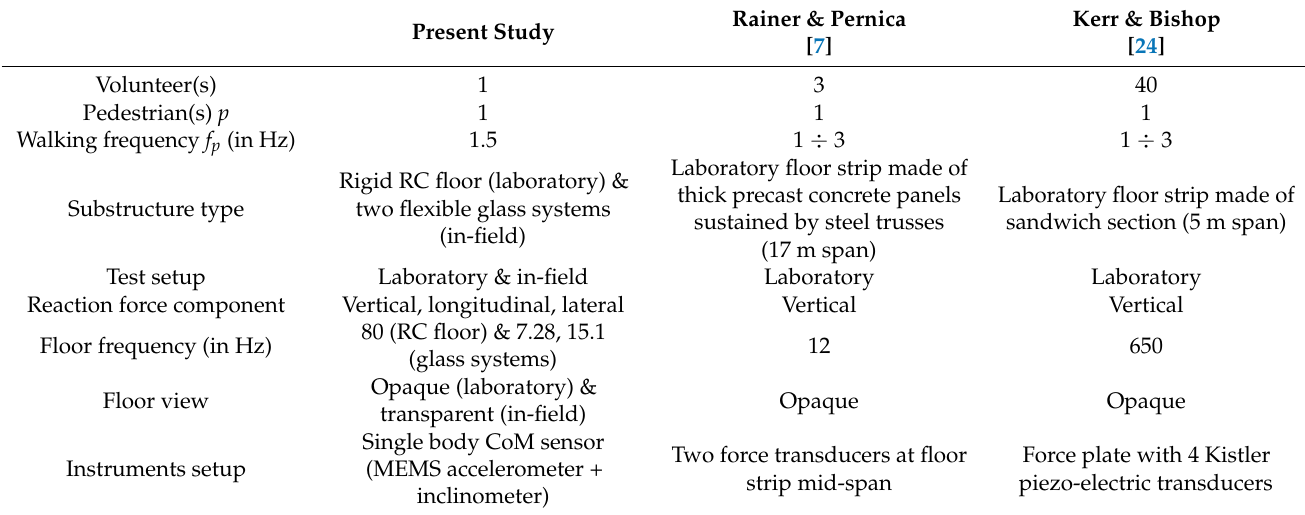
Table 1. Summary of selected experimental configurations for DLF estimations of human-induced reaction forces and comparisons.